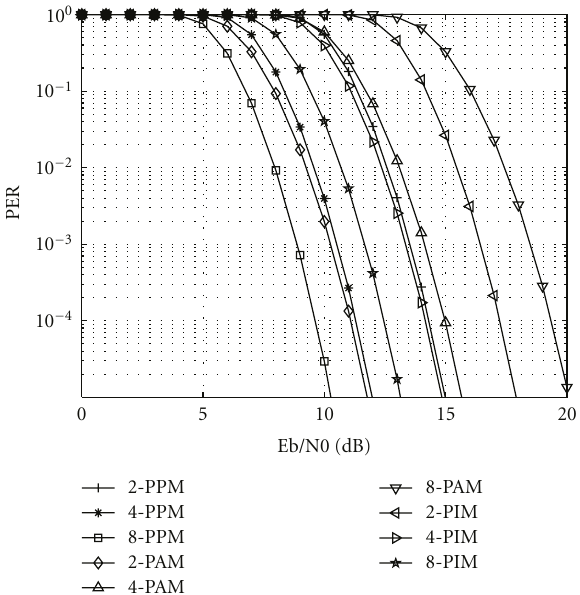
Figure 6: PER performance comparison of PAM, PPM, and PIM for the same bit energy.